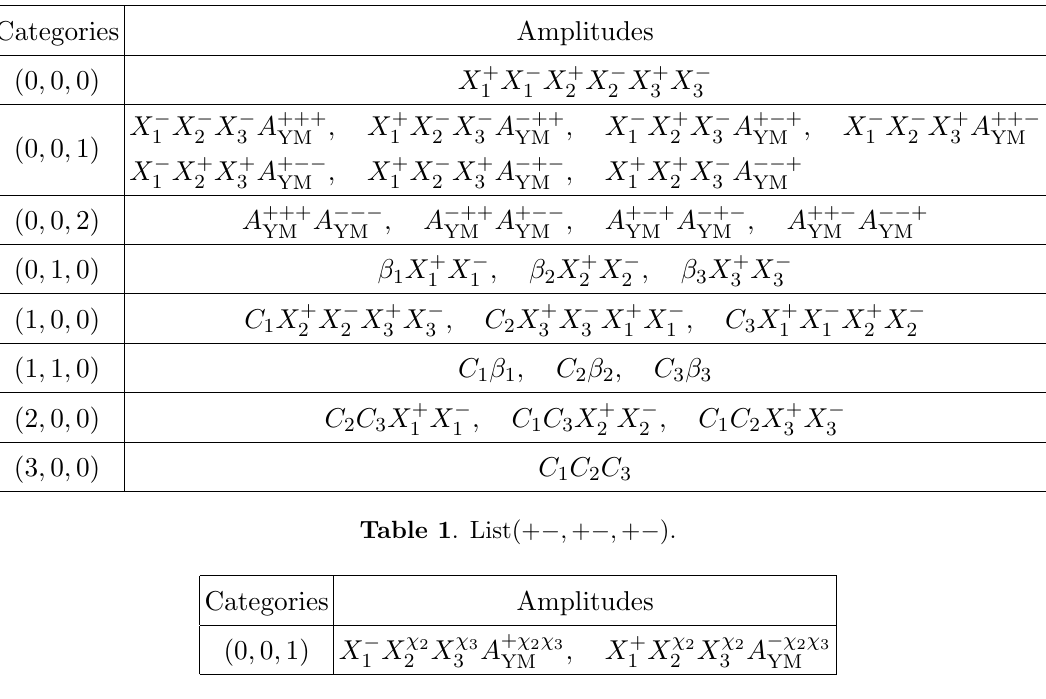
Table 2 . Truncation of List(+ (cid:0) ; (cid:31) 2 (cid:31) 2 ; (cid:31) 3 (cid:31) 3